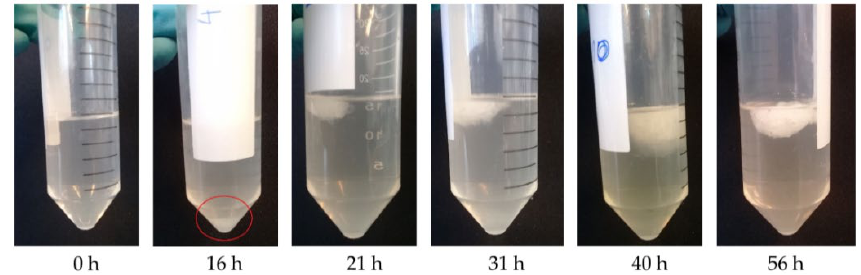
Figure A7. Alginate aggregates re-suspended from samples of culture #2 taken at different times.